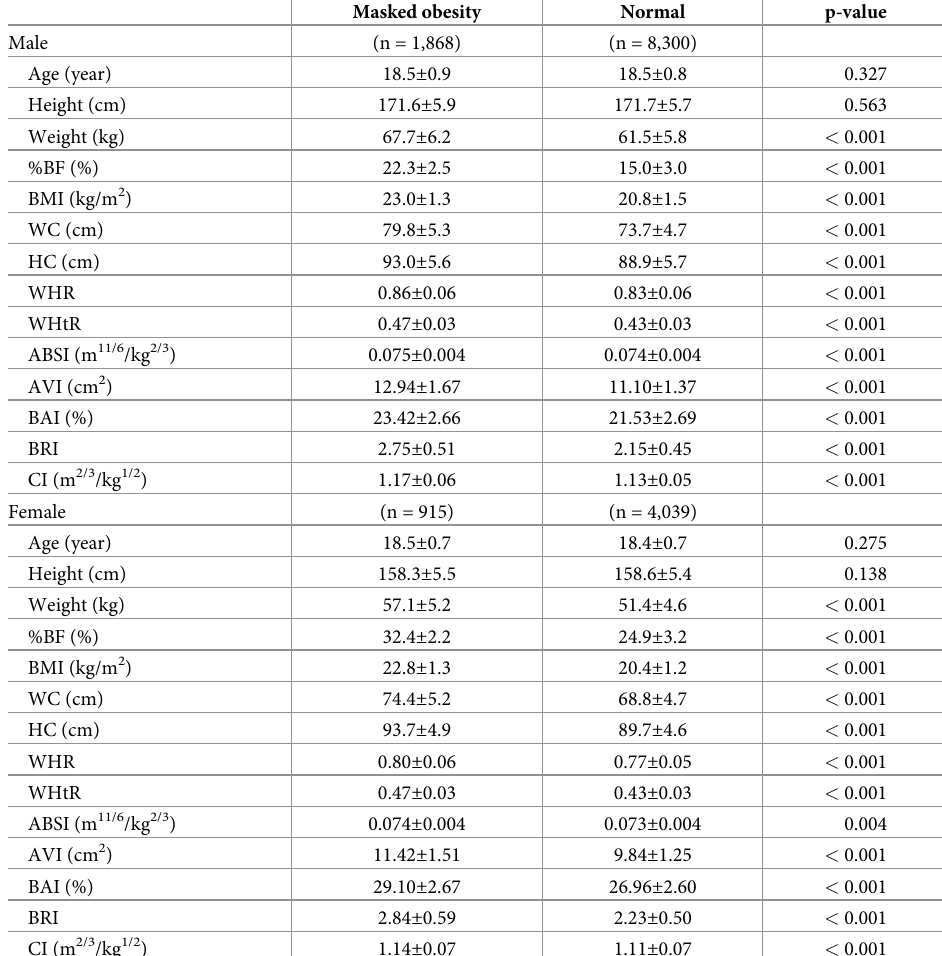
Table 1. Comparison of anthropometric indices of university students with the masked obesity and normal groups. Masked obesity Normal